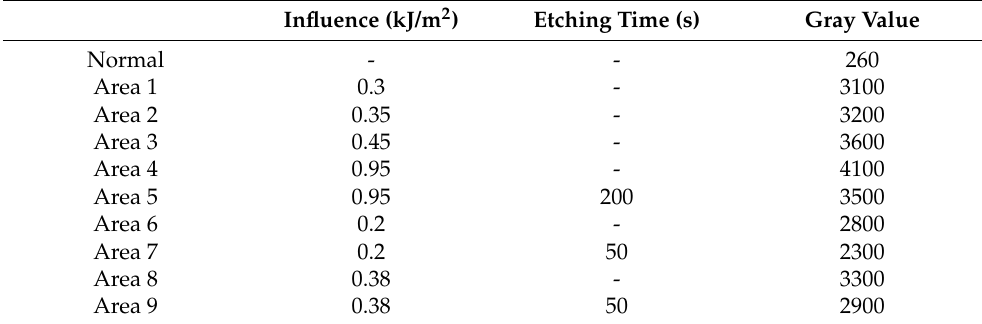
Table 1. Gray value measurements of microstructured areas (fabricated under different process conditions) and unprocessed area of CMOS image sensor at an integration time of 82